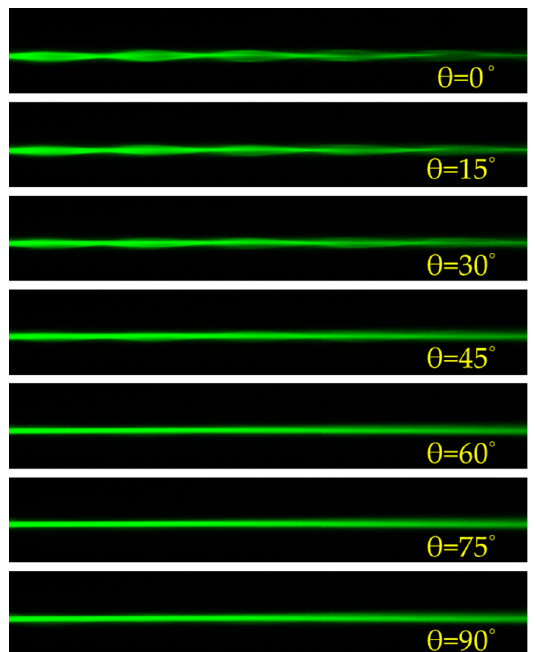
Figure 4. The polarization dependence of the incident laser beam on the self-focusing with the applied voltage of 1.8 V.